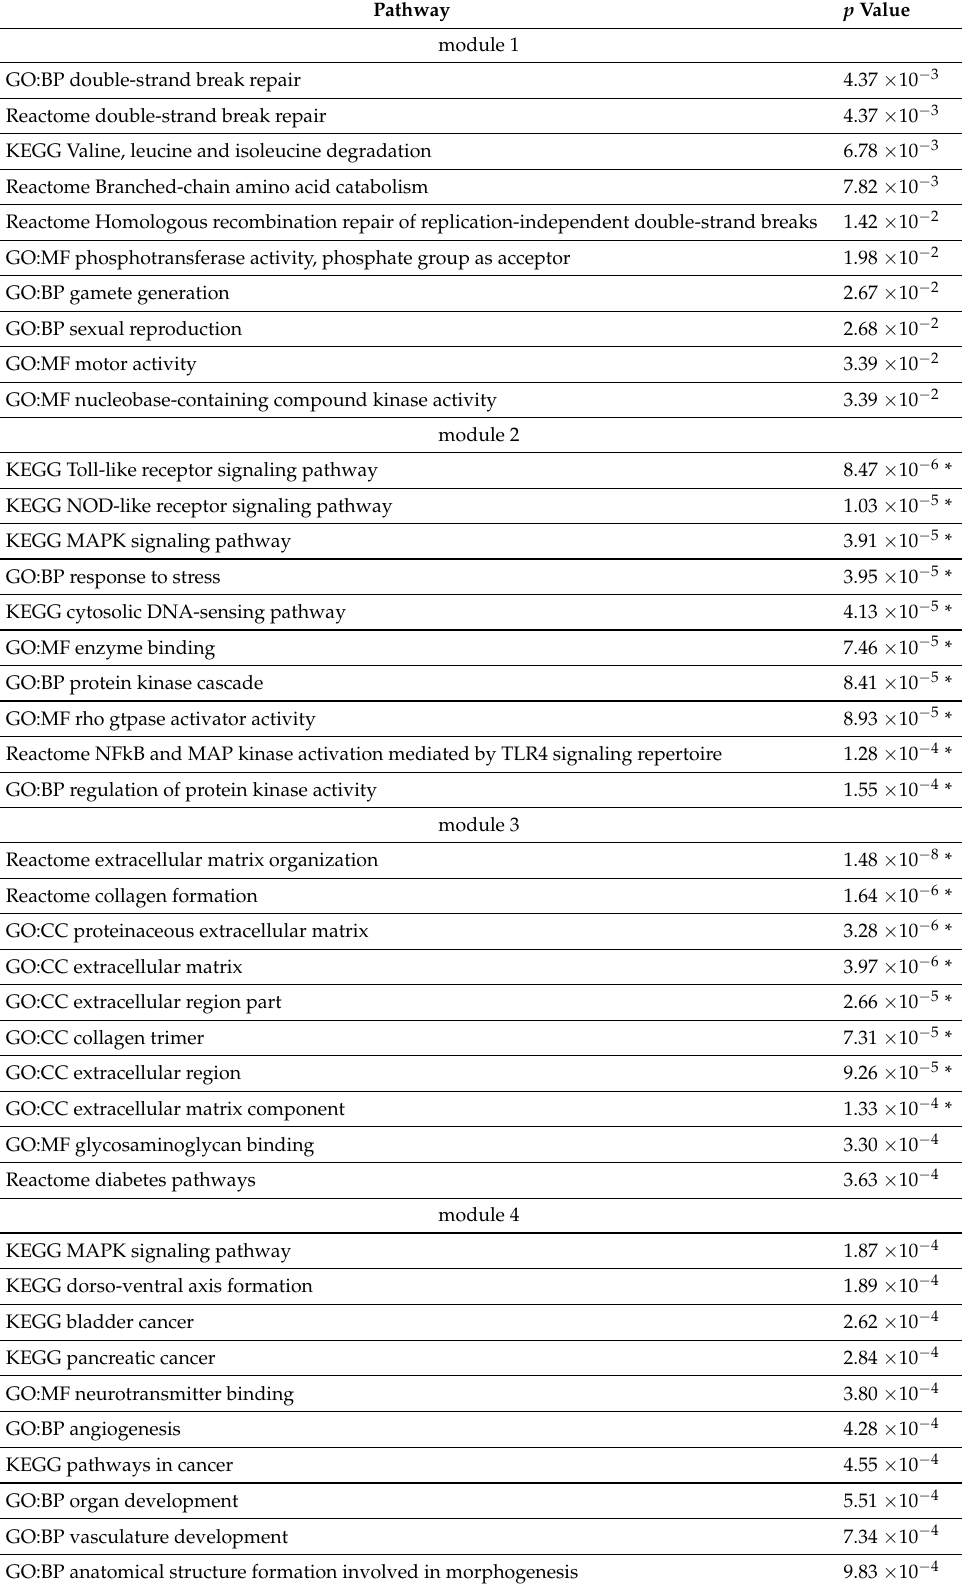
Table 4. The pathway enrichment analysis of each module by GO, KEGG, and Reactome pathway databases for the lung disease dataset. The * sign indicates the p -value is significant under a false discovery rate of